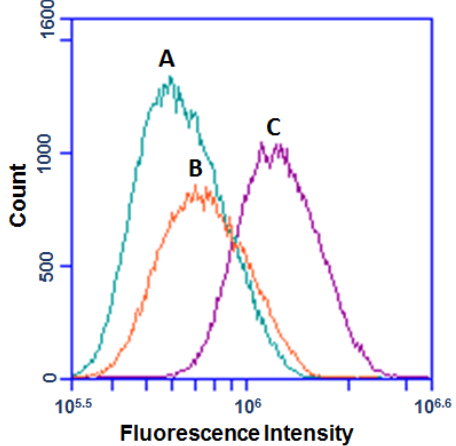
Figure 5. Flow cytometry measurements of cellular DOX level in C6 cells following 4 h incubation with ( A ) DOX-loaded PEG-PU-PEG micelles, ( B ) DOX-loaded PEG-PU(SS)-PEG micelles, and ( C ) free DOX·HCl. (DOX dosage: 30 μg/mL, cell counts were 10,000)